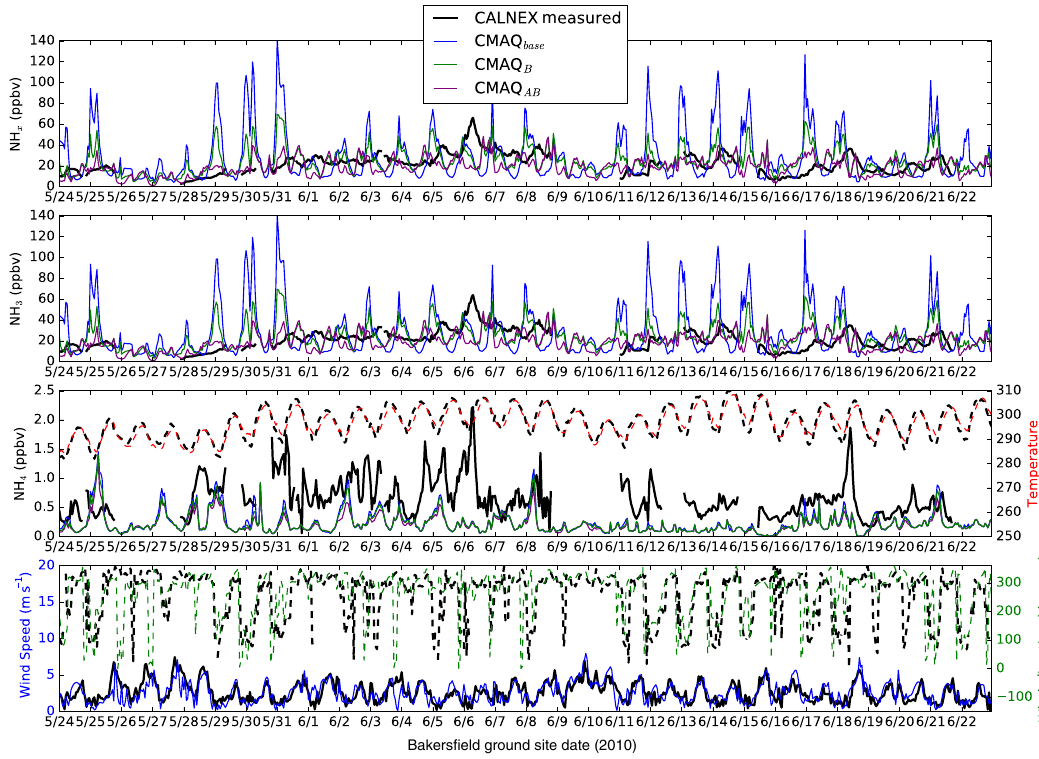
Figure 4. The CalNex ground measurements at the Bakersfield site (solid black) compared to the CMAQ base (solid blue), CMAQ AB (purple) and CMAQ B (green) simulations for a month of model runs. The top panel (a) shows NH x , (b) shows NH 3(g) , (c) NH 4(p) , and temperature (K) and (d) wind speed on the left and wind direction on the right